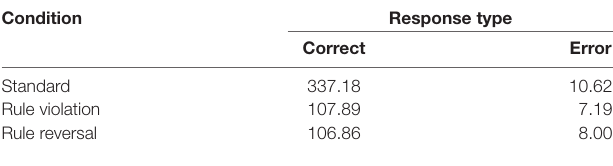
TABLE 1 | Mean number of trials for each combination of instruction condition and response type that were included in statistical analyses.